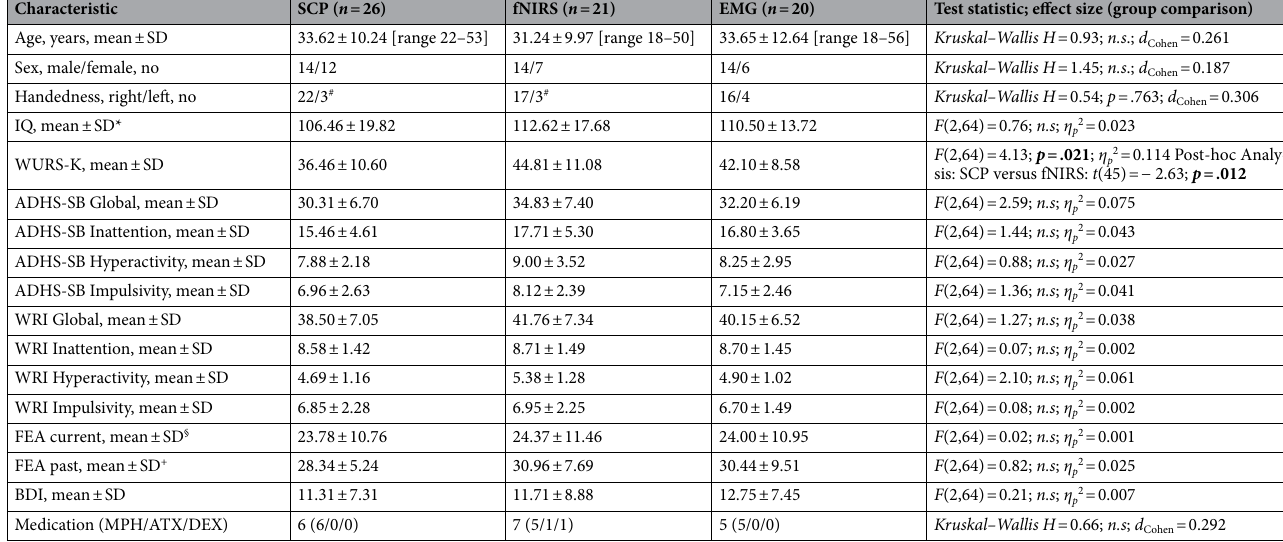
Table 1. Sample characteristics. Note. ADHS‑SB = German ADHD self-rating scale for symptoms in adulthood 35,36 ; ATX = Atomoxetine; BDI = Beck Depression Inventory 47 ; d Cohen = , effect size Cohen’s d; DEX = Dexamphetamine; MPH = Methylphenidate; n.s . = not significant; WRI = Wender-Reimherr- Interview 35,36 ; WURS‑K = short version of the German Wender Utah Rating Scale for ADHD childhood symptoms 33,34 ; SD = standard deviation; η p 2 = partial Eta squared. *IQ was assessed based on the Culture Fair Intelligence Test, Scale 2-revised (CFT-20-R) 31 . # Information missing for 1 participant. + Information missing for 32 participants. § Information missing for 25